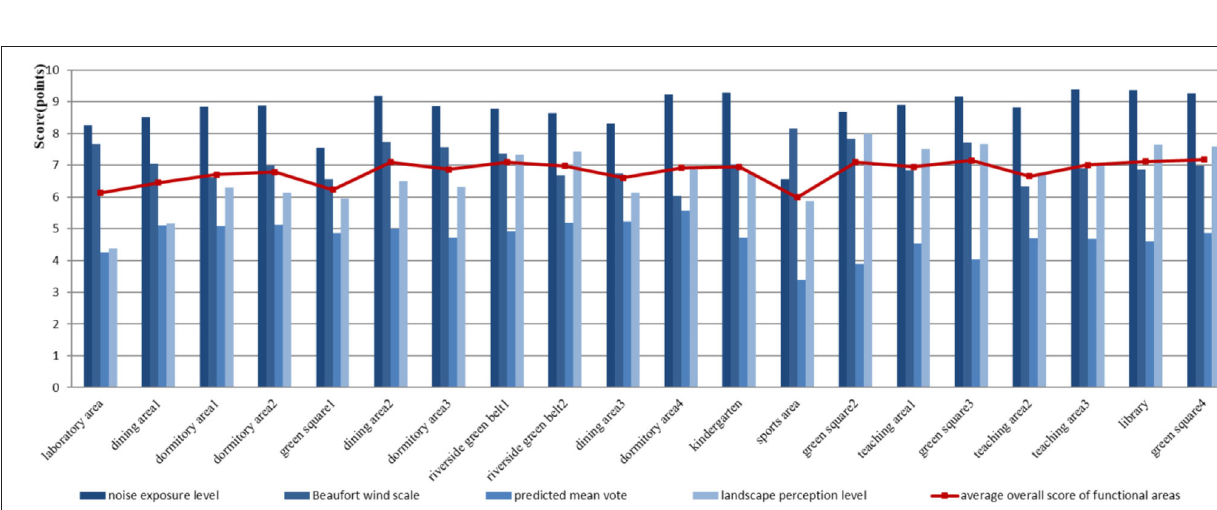
FIGURE 8 | Spatial visualization of quantified scoring results in health-related physical environment.